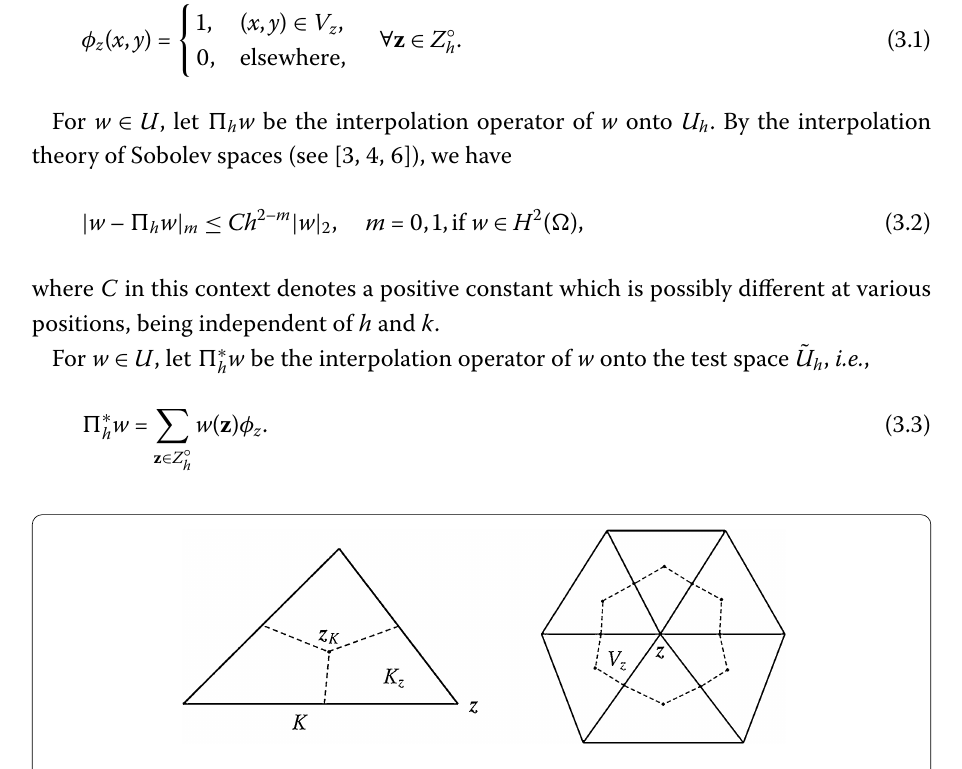
Figure 1 Triangle element and control volume. The left chart is a triangle K partitioned into three sub-regions K z . The right chart is a sample region with dotted lines indicating the corresponding control volume V z